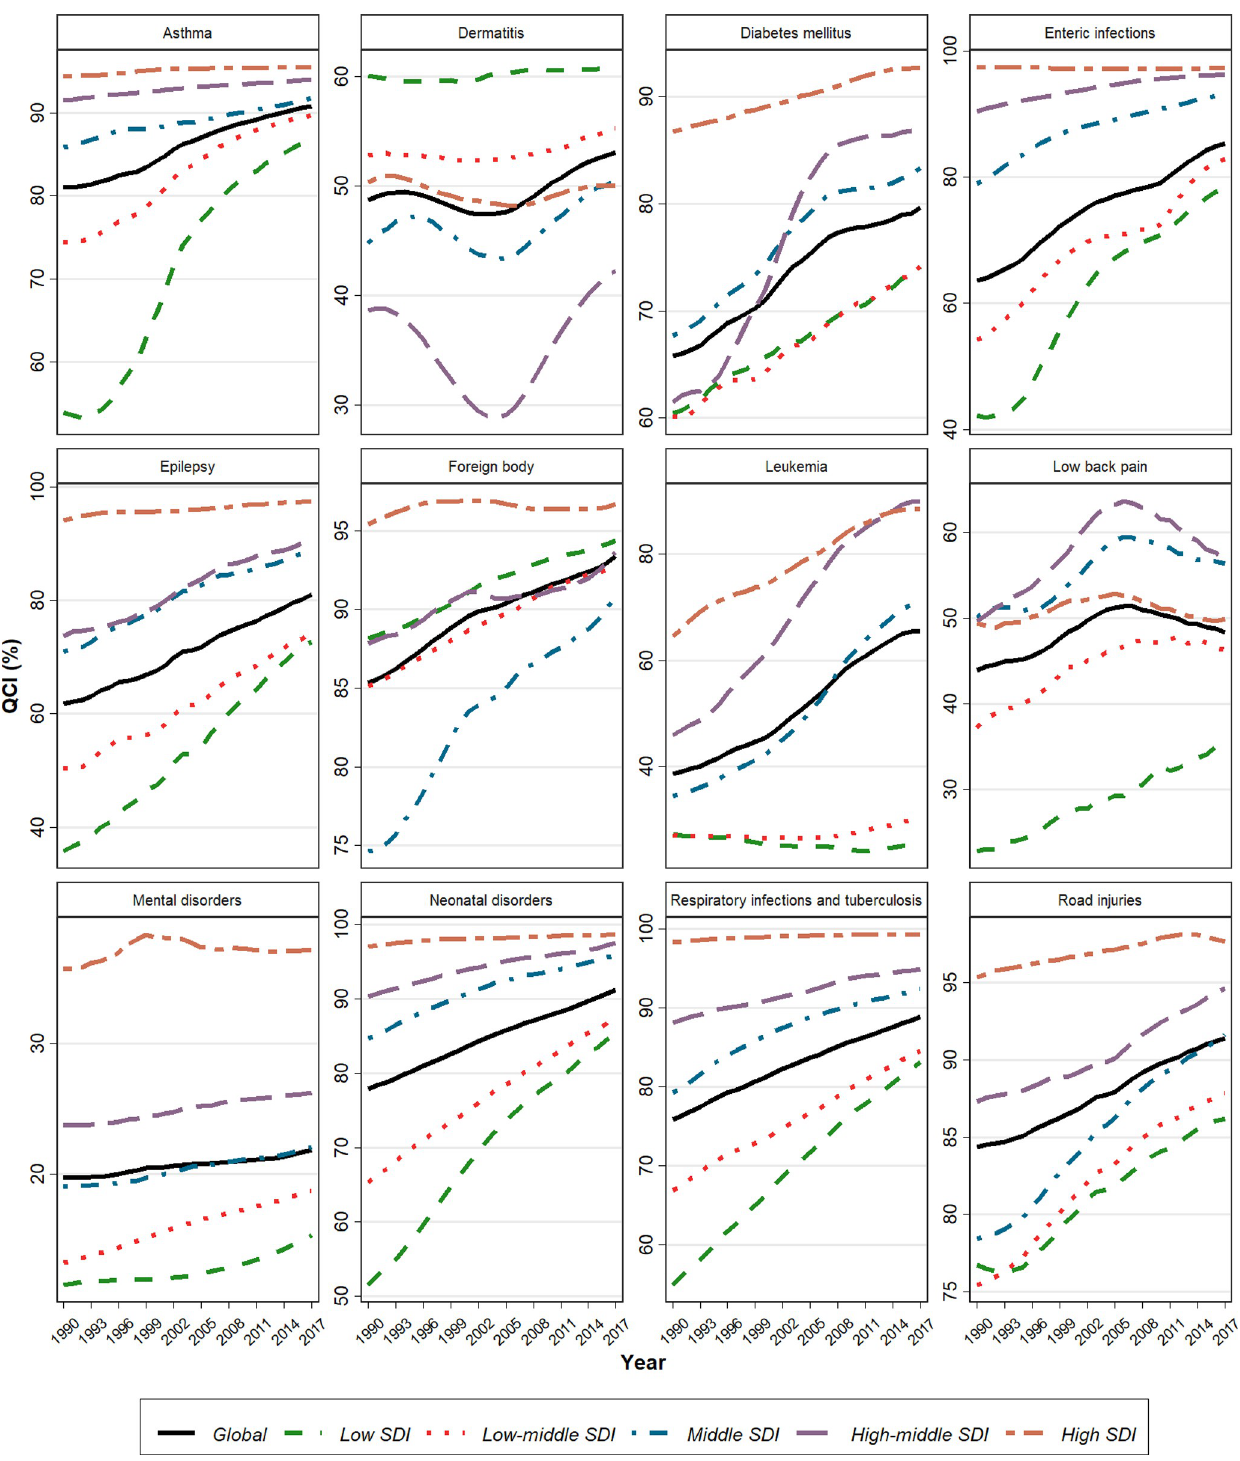
Fig 1. Map of Percent change in deaths rate due to all causes in under 20y population between 1990 and 2017. (Republished from https://www. openstreetmap.org/under a CC BY license, with permission from https://www.openstreetmap.org/copyright, original copyright 2020).